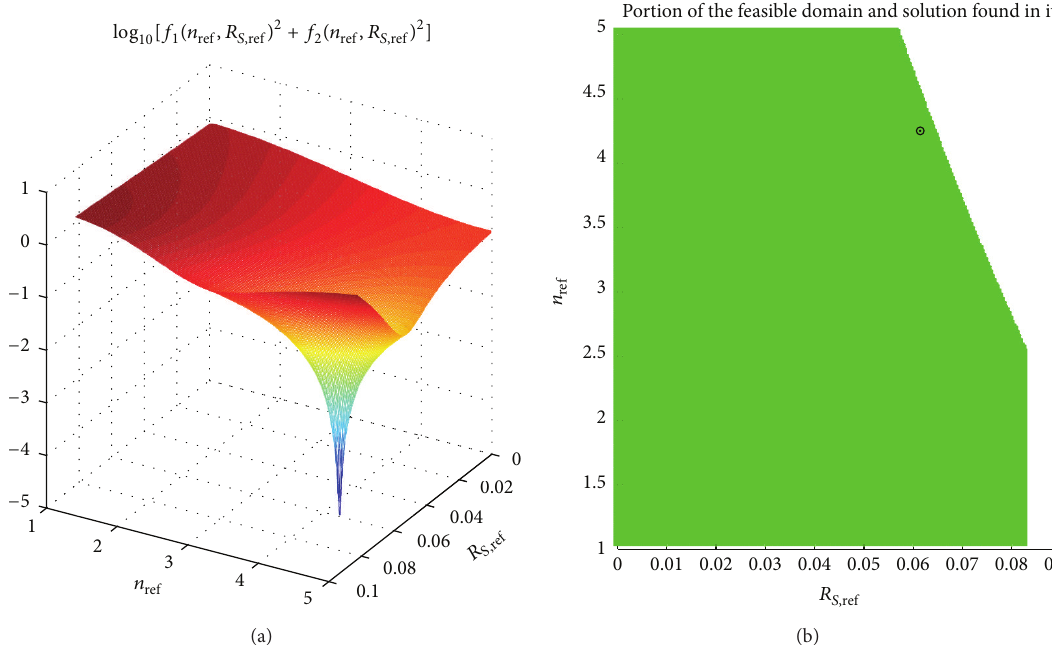
Figure 4: Graph of the functional (25) and feasible domain for the PV panel Xunlight XR12–88 panel (thin film technology). A unique physical solution exists.